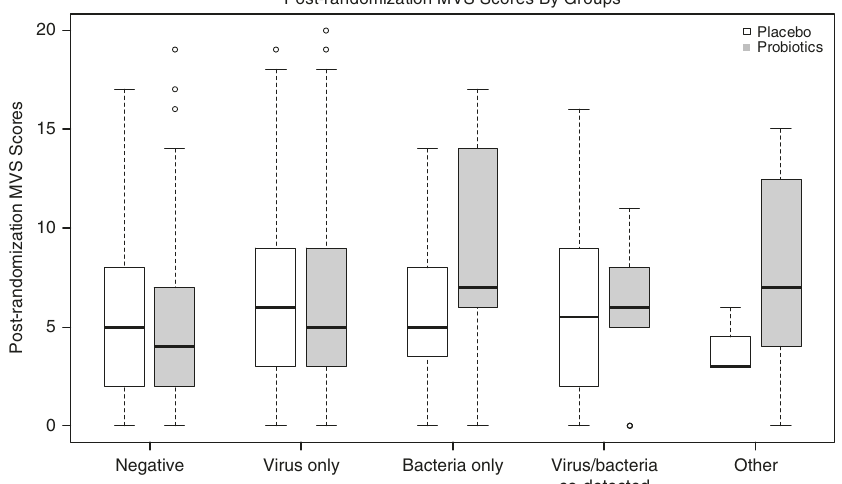
Fig. 2 Post randomization disease severity (Modi fi ed Vesikari Scale scores) based on pathogen identi fi ed, compared between probiotic and placebo groups. Boxplots of post-randomization modi fi ed Vesikari scale cores by treatment and pathogen groups (Tested negative: placebo n = 160, probiotics n = 139; virus only: placebo n = 219, probiotics n = 232; bacteria only: placebo n = 20, probiotics n = 17; virus/bacteria co-detection: placebo n = 6; probiotics n = 13; Other type detected including parasite only and virus/parasite co-detection: placebo n = 3, probiotics n = 7). In the box plot, the line that divides the box into two parts represents the median of the data; the upper and lower bounds of the box represent the 25% and 75 percentiles, respectively. The lower whiskers represent the 25%ile-(1.5× IQR) and the upper whiskers represent the 75%ile-(1.5× IQR). The dots beyond the whisker represents outliers of values within the dataset. Source data are provided as a Source Data fi le.